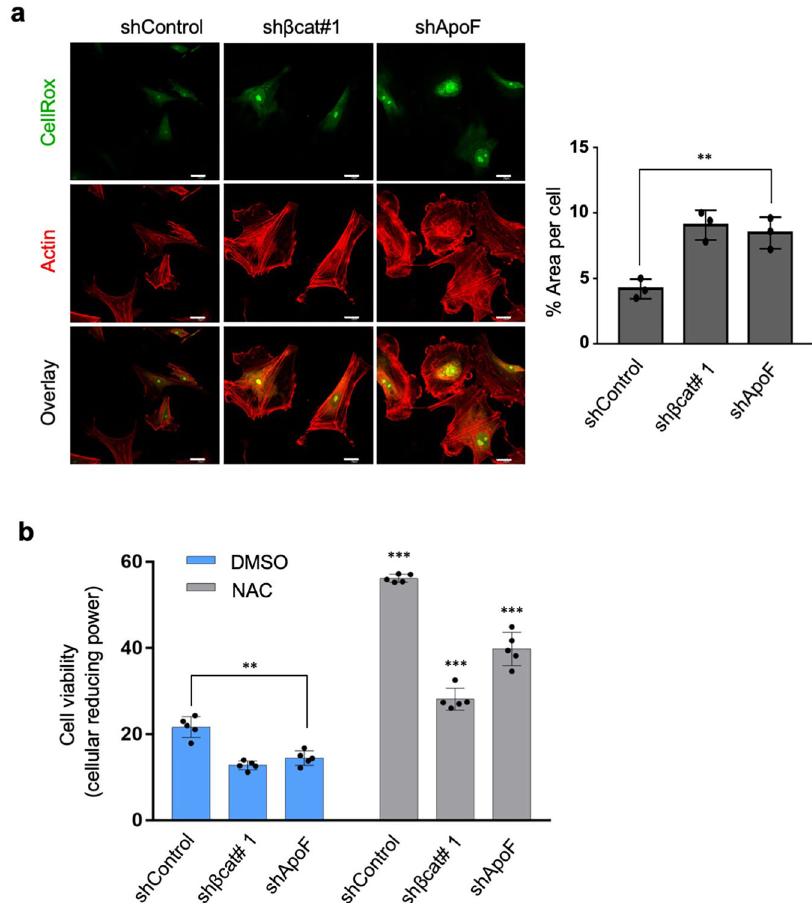
Fig. 8 Induction of oxidative stress and decreased cell viability under β -catenin and ApoF knockdown conditions. a Immuno fl uorescence images showing elevated oxidative stress detected by CellRox upon β -catenin or ApoF knockdown. Scale bars, 20 μ m. (left) Quantitative analysis of the CellRox in control, β -catenin , and ApoF knockdown NSFs (right). Data are expressed as the mean ± standard deviation ( n = 3 biologically independent experiments) (lower graph); ** P < 0.01, Student ’ s unpaired t test. b Alamar Blue assay showing decreased viability of NSFs upon β -catenin or ApoF knockdown, which was restored by treatment with NAC. Data are expressed as the mean ± standard deviation (n = 5 biologically independent experiments). ** P < 0.01 and *** P < 0.001, Student ’ s unpaired t